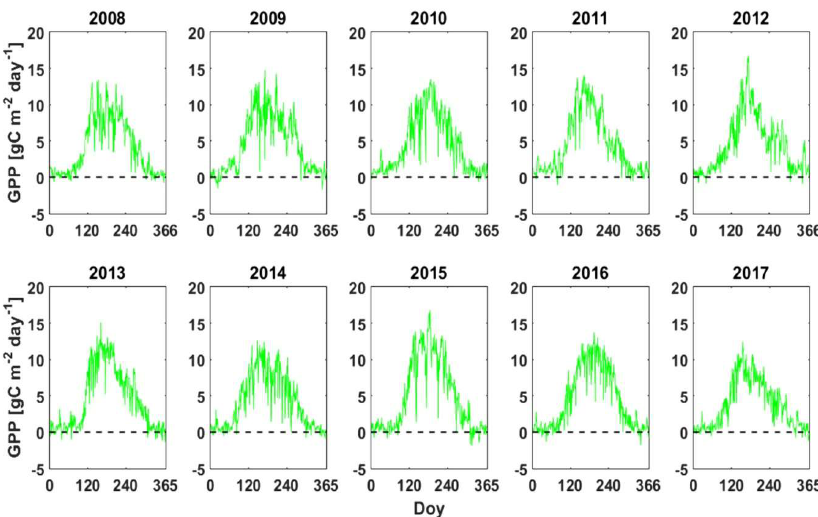
Figure 7. Daily values of GPP in Jastrebarsko forest during 2008–2017. Forests 2018 , 9 , x FOR PEER REVIEW